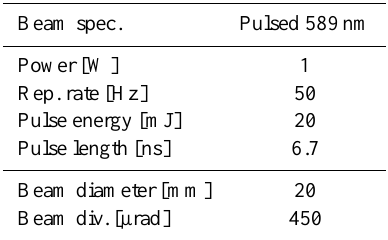
Table 1. Beam specifications for the ALOMAR Na lidar, including lidar field of view (as of 21 December 2010). For the 589nm laser beam, only data for the D 2 a frequency is given. Beam divergence is given as full angle. Pulse length is given as full width at half maximum (FWHM).